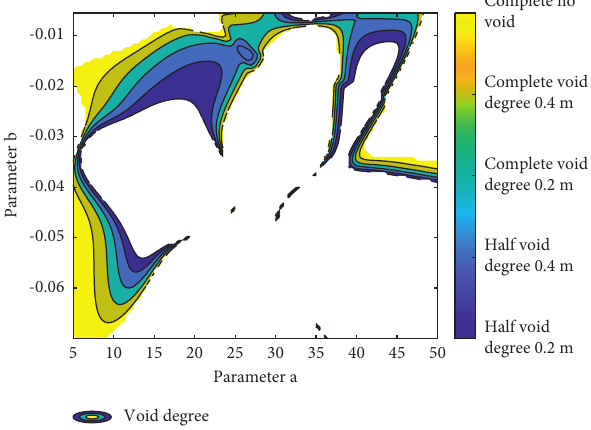
Figure 21: Values of parameters a and b under different void degrees. Table 10: Deflection value detection of first stage loading in void section.